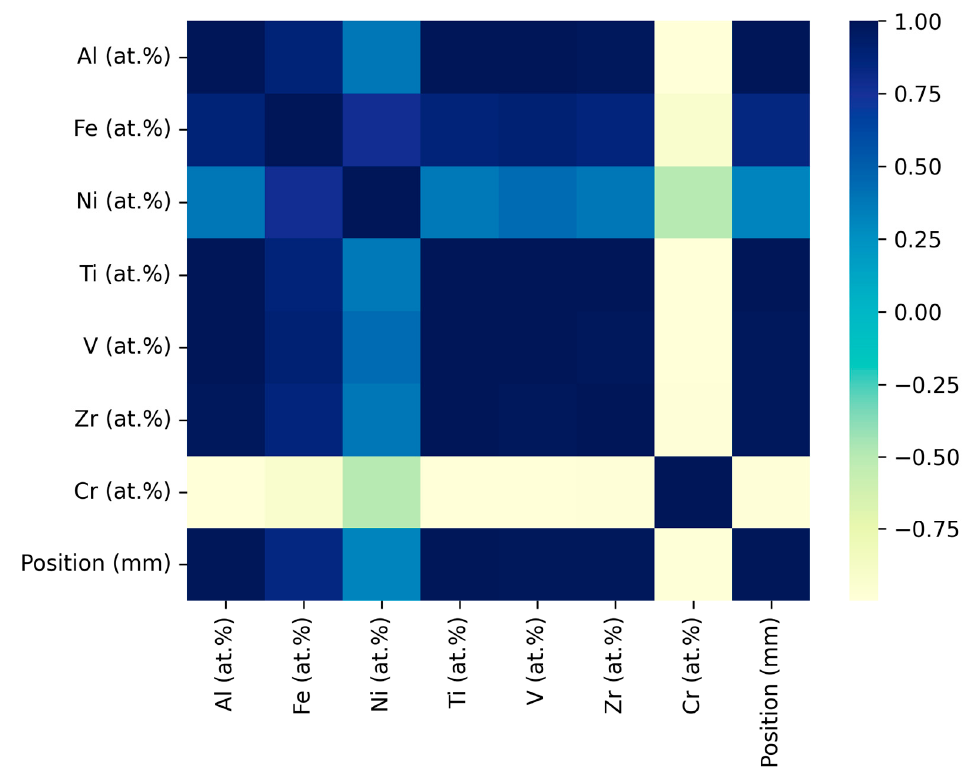
Figure 3. Correlation matrix between variables and output of the models.